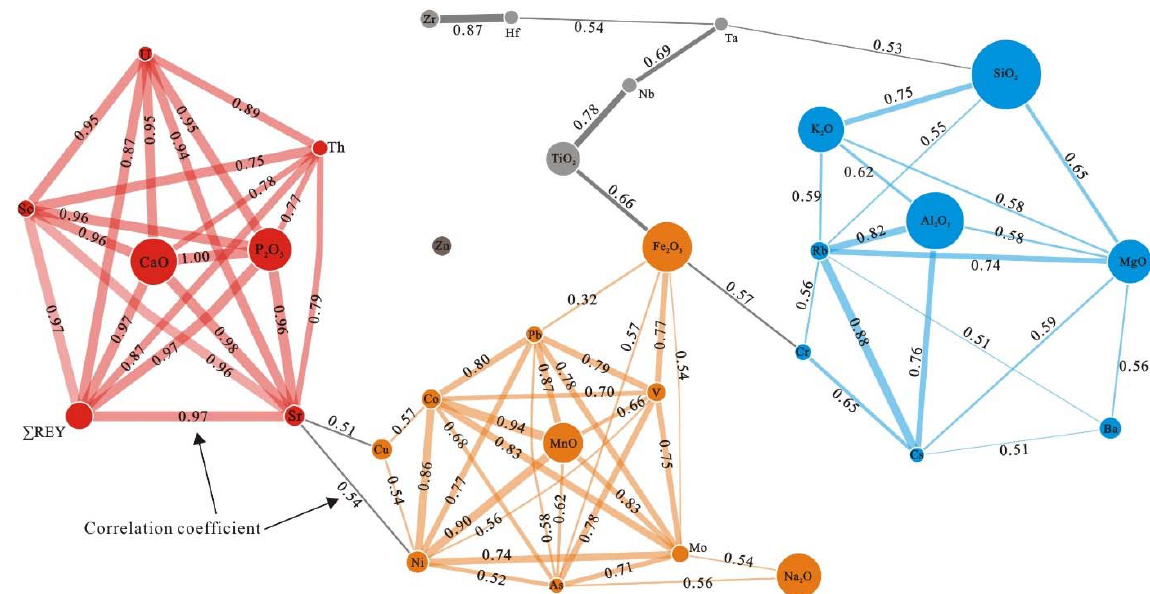
Figure 7. Knowledge map of element correlations for deep sea sediments off Minamitorishima Island; data are from Table S3. Node size reflects the average content of elements, and line thickness reflects the correlation coefficient between elements, which satisfies the following two formulas: nodes size (mm) = (Ln([average content × 10]) 3 − 7.8) × 8/3660 + 2. The units are as follows: average content, ppm; lines size, pound, which = 1.4 × ([related coe ffi cient] − 0.5)/0.5 + 0.1.